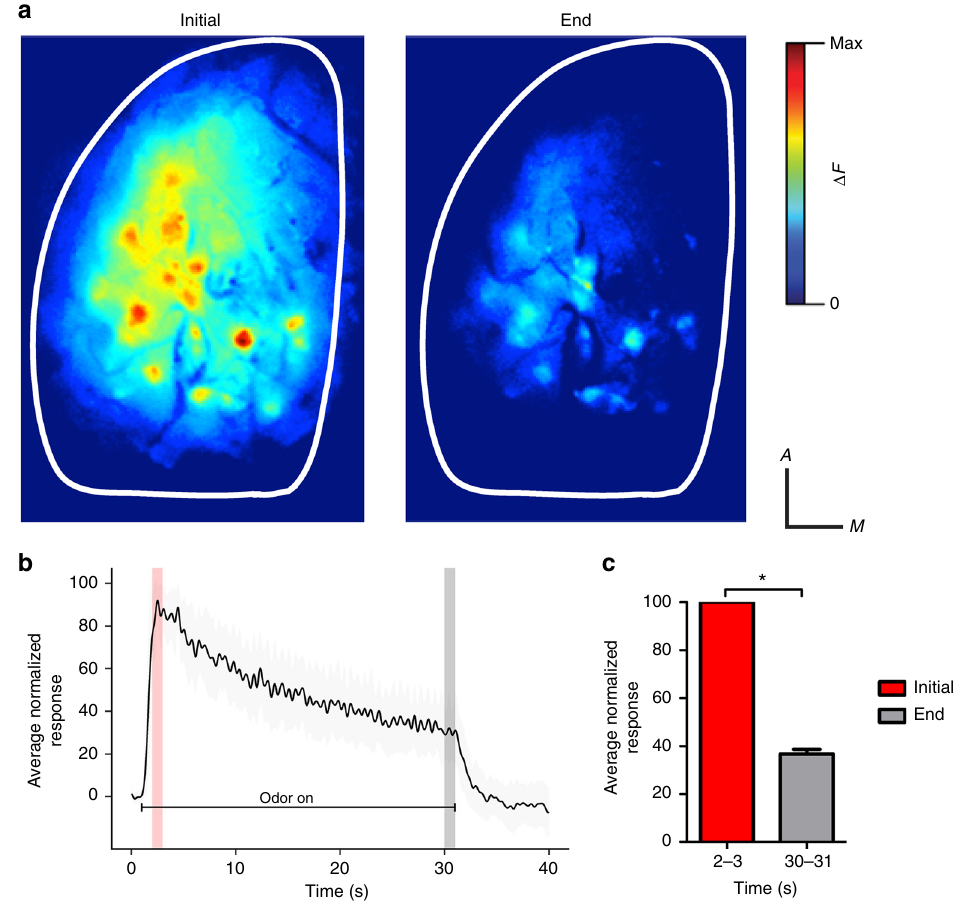
Fig. 1 Glomerular responses to a prolonged odor presentation habituate over time in anesthetized mice. a Pseudo-color glomerular responses to 2- heptanone (0.3% s.v.) initially and after 30 s of the odor presentation. b The average fl uorescence trace (% of initial response ± s.e.m.) from all recorded glomeruli ( n = 96, 6 mice). c The average glomerular odor response (% of initial response ± s.e.m) decreases during the odor presentation. * p <